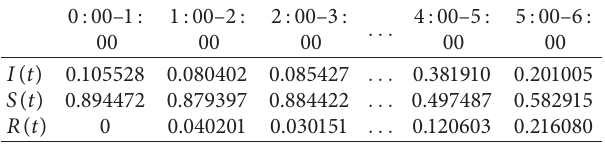
Table 6: Samples of I ( t ) , S ( t ) , and R ( t ) statistics of October 1, 2015.